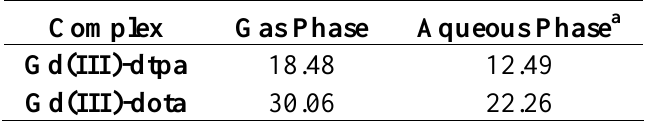
Table 4. Activation energy (in kcal/mol, DFT level) for the first step of the